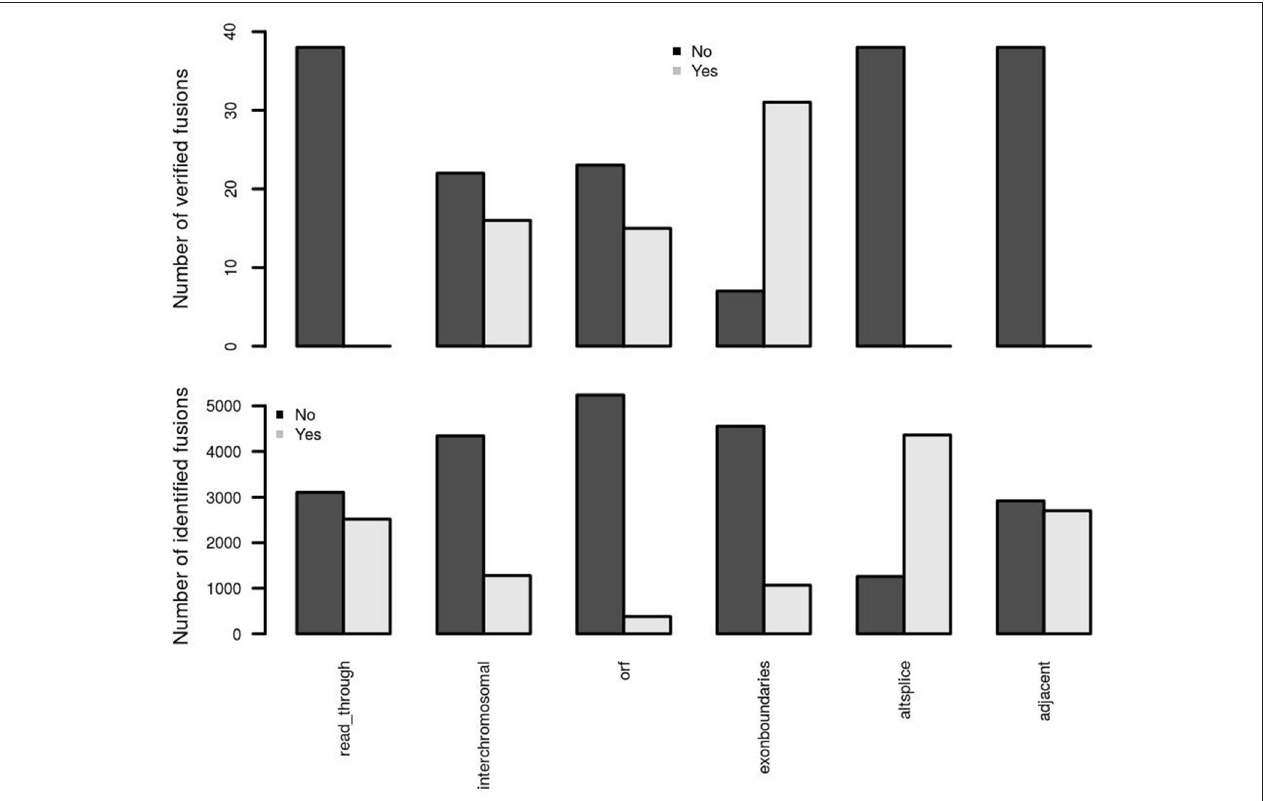
FIGURE 4 | Important feature distributions between verified and identified fusions. In the first training dataset, the verified fusions ( n = 38) do not have any feature of read-through, alternative splicing and adjacent genes (which may also be partly due to a selection bias in those fusions selected for verification). Comparing with identified fusions, higher ratios of interchromosomal, open reading frame (orf) and exon boundaries in verified fusions were